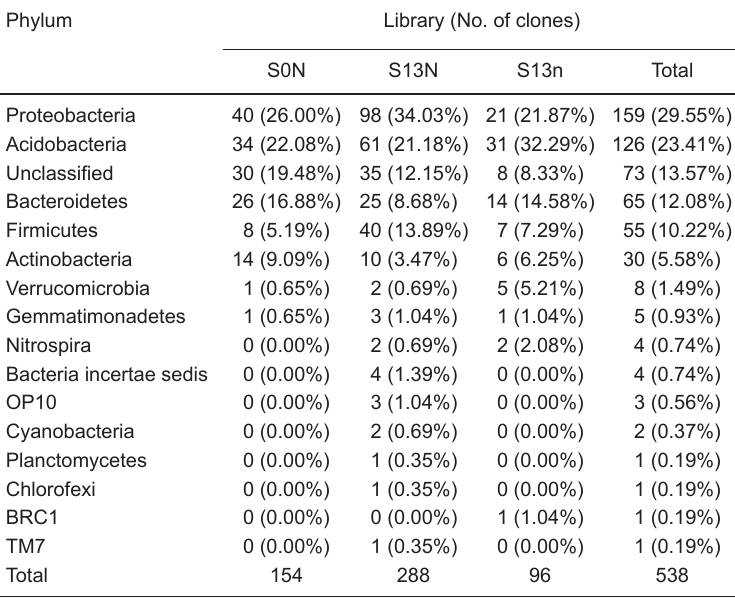
Table 2. Phylum distribution in soil of sugarcane